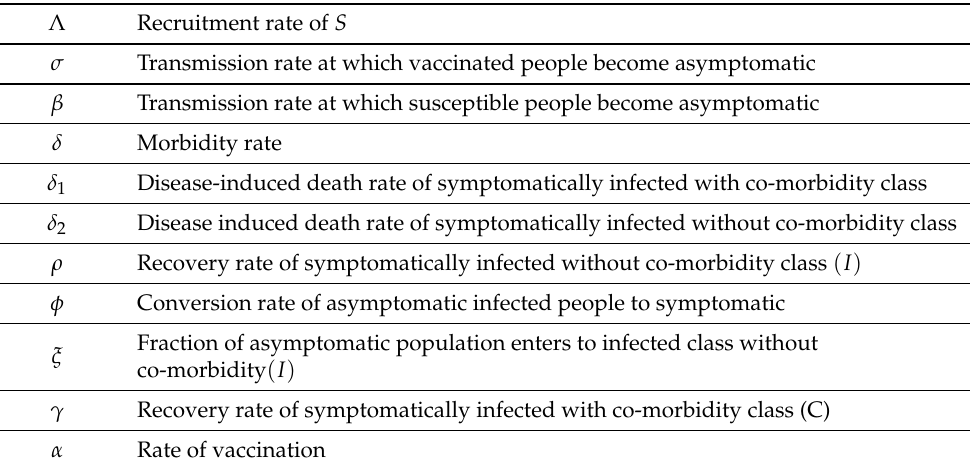
Table 1. Description of parameters used in the system